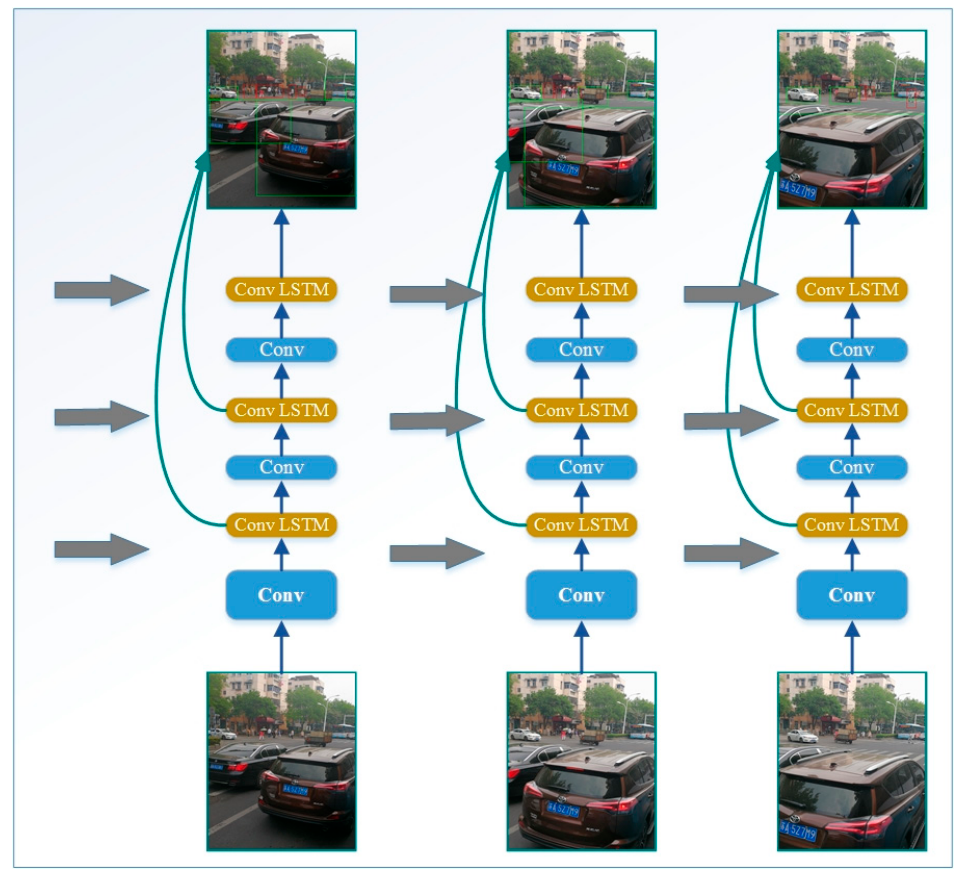
Figure 9. Mobile video object detection framework based on time-aware feature mapping.